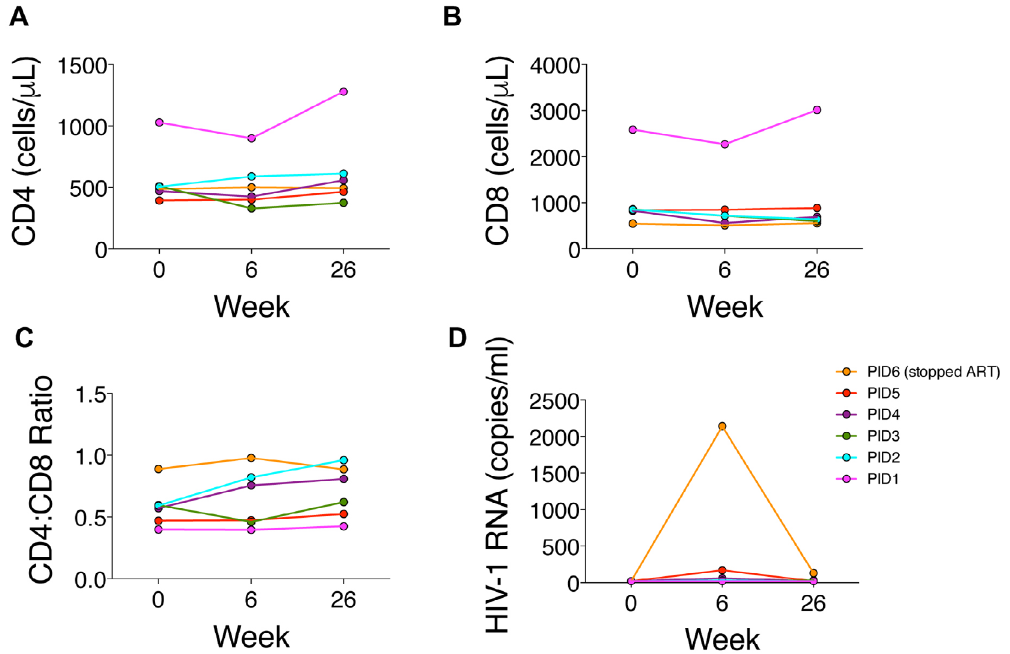
Figure 1 . Changes in HIV parameters during treatment period (weeks 0 to 6) and after 20 weeks of follow- up without